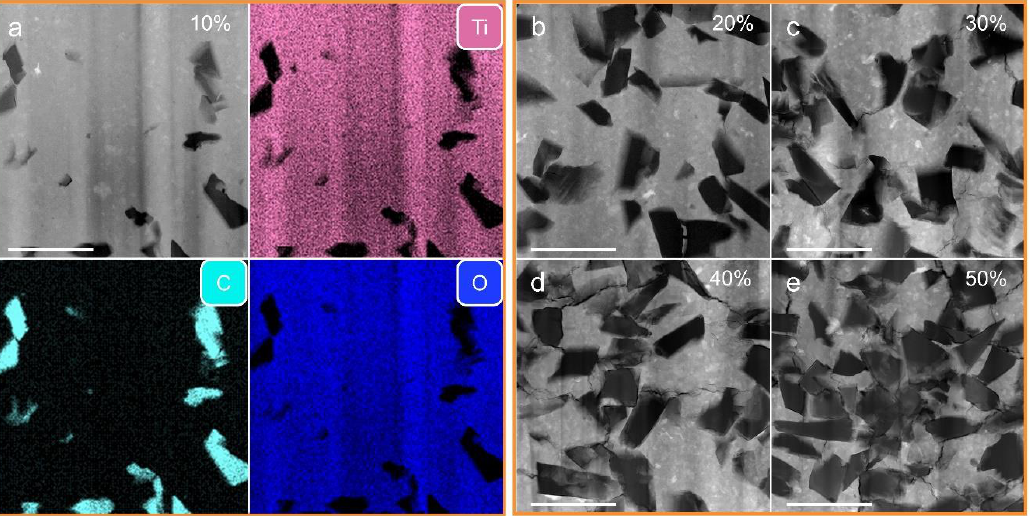
Figure 4. HAADF images of the TiO 2 -diamond composites. ( a ) T-10%D, ( b ) T-20%D, ( c ) T-30%D, ( d ) T-40%D, ( e ) T-50%D. The corresponding EDS maps of the T-10%D sample are also given in ( a ). The scale bars are 1 μm.